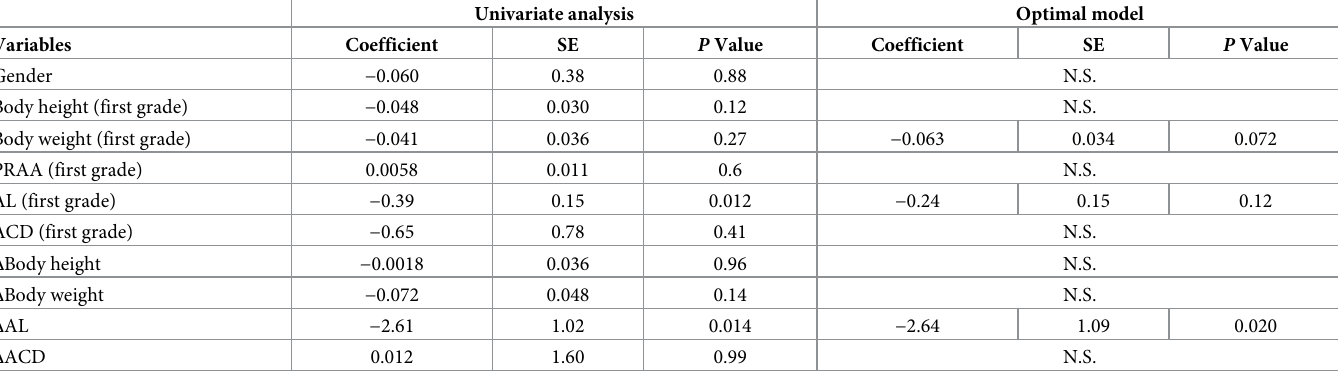
Table 4. The relationships of the change in the PRAA with sex, body height (first grade), body weight (first grade), PRAA (first grade), AL (first grade), ACD (first grade), Δ body height, Δ body weight, Δ AL, and Δ ACD in the RVS(+) group.